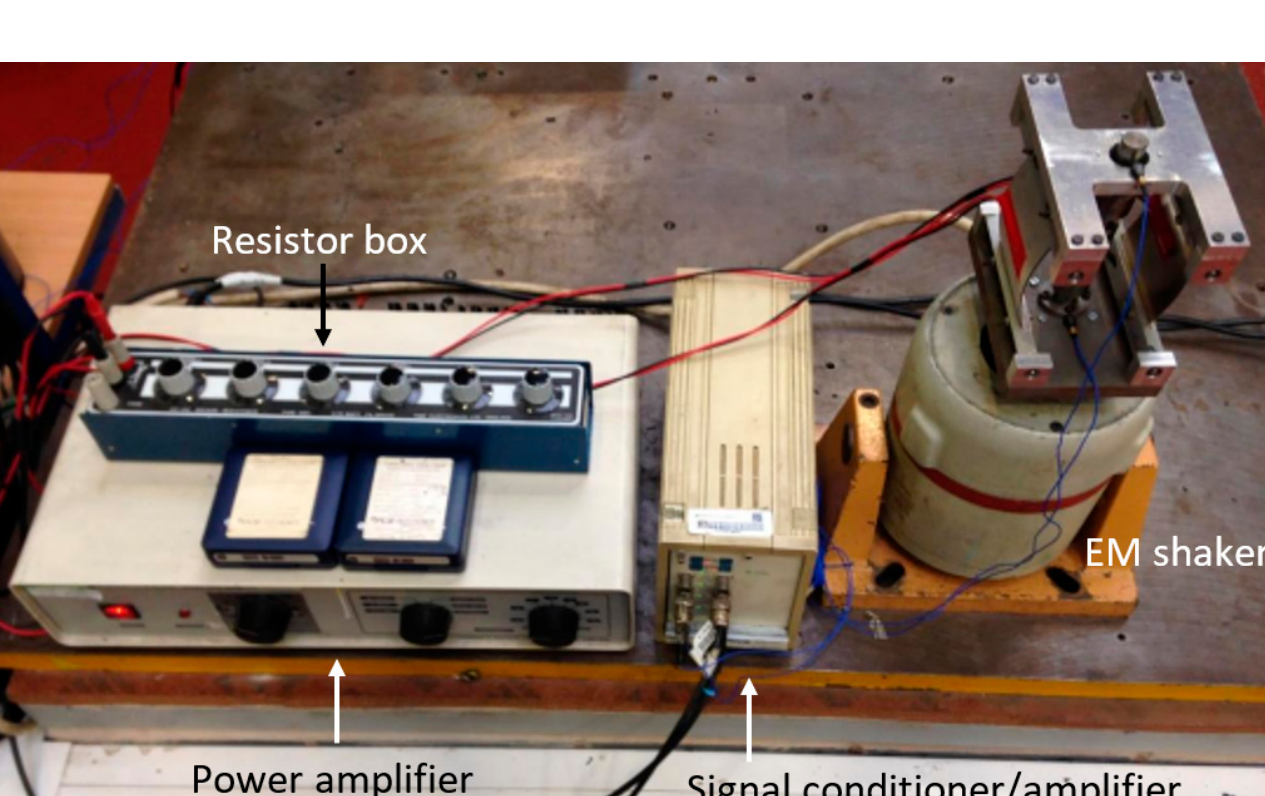
Figure 6. Schematic diagram of the experimental setup and its instrumentation.